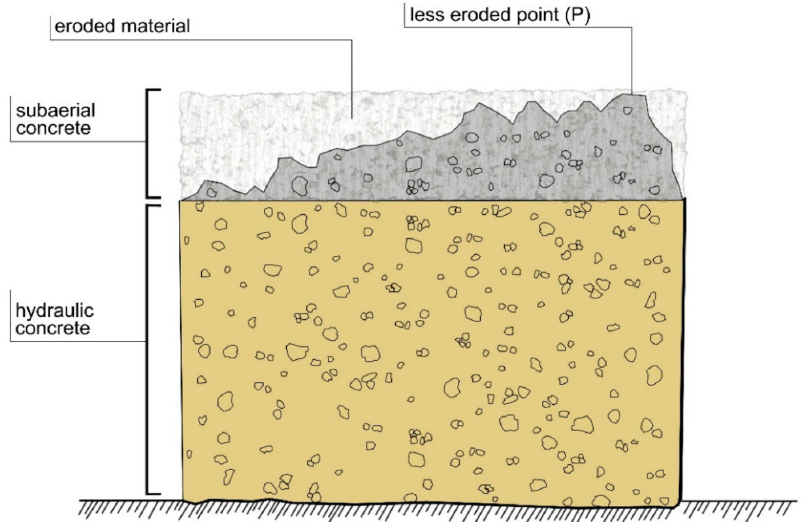
Figure 17. Sketch of the pila with the concrete layer before its erosion and the limit between subaerial and hydraulic concrete.